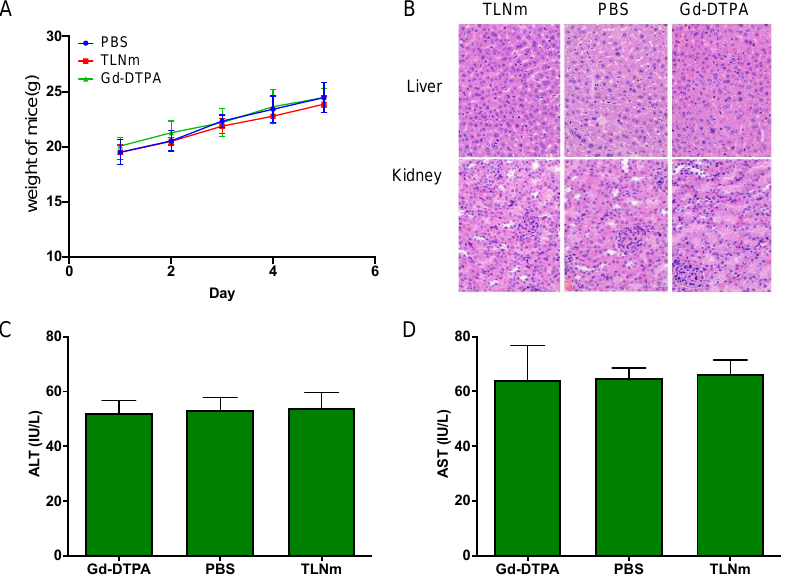
Figure 6. The weight change of KM mice five days after an injection of TLNm, Gd-DTPA at a dose of 0.1 mmol Gd/kg, and PBS ( A ). Tissues were recovered 5 days after an injection of TLNm, Gd-DTPA at a dose of 0.1 mmol Gd/kg, and PBS. H&E-stained liver and kidney tissues (magnification, 200 × ) ( B ). The values of ALT ( C ). The values of AST ( D ).